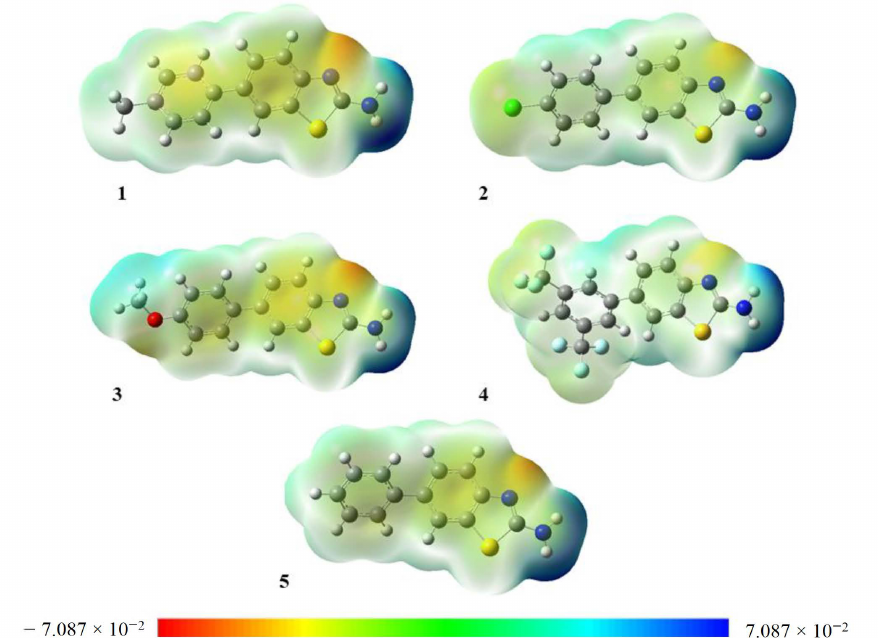
Figure 4. Molecular electrostatic potential maps of 1 – 5 plotted using iso value = 0.0004. Units of the scale of electron charge density are